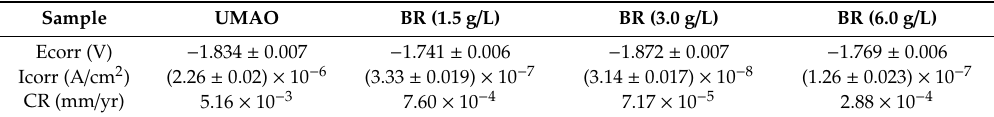
Table 4. Corrosion current densities and corrosion potentials for di ff erent coatings in SBF at 37 ± 1 ◦ C. Icorr, corrosion current density; Ecorr, corrosion voltage; CR, corrosion